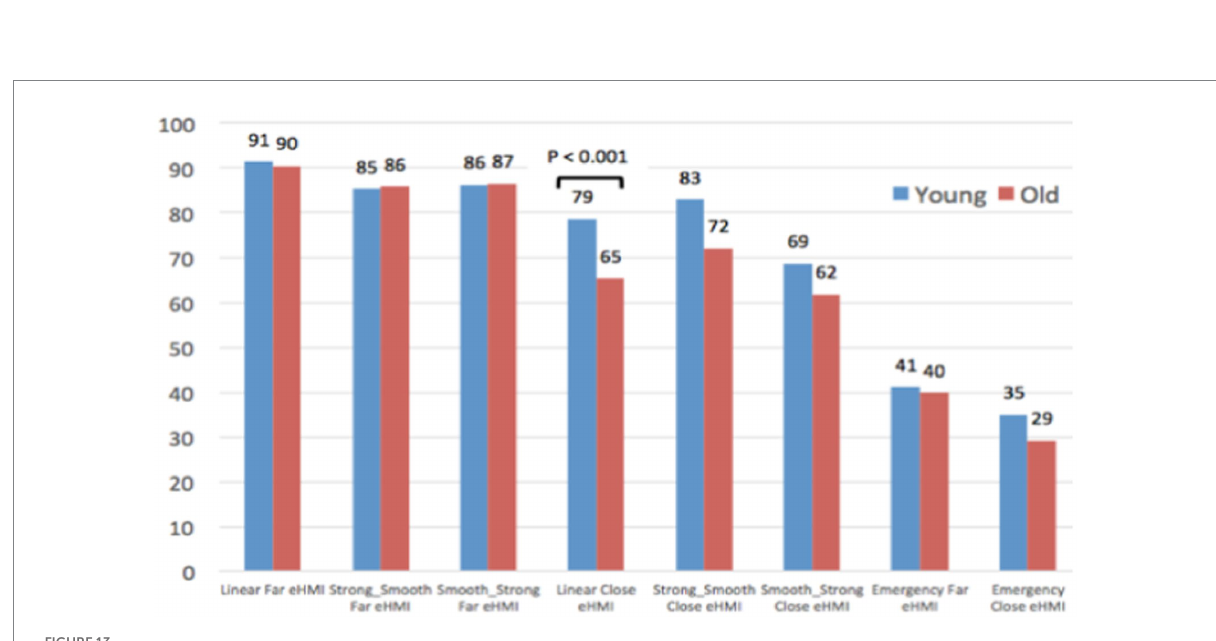
FIGURE 13 Safety assessment of AV (with eHMI) behavior to yield, as an AV